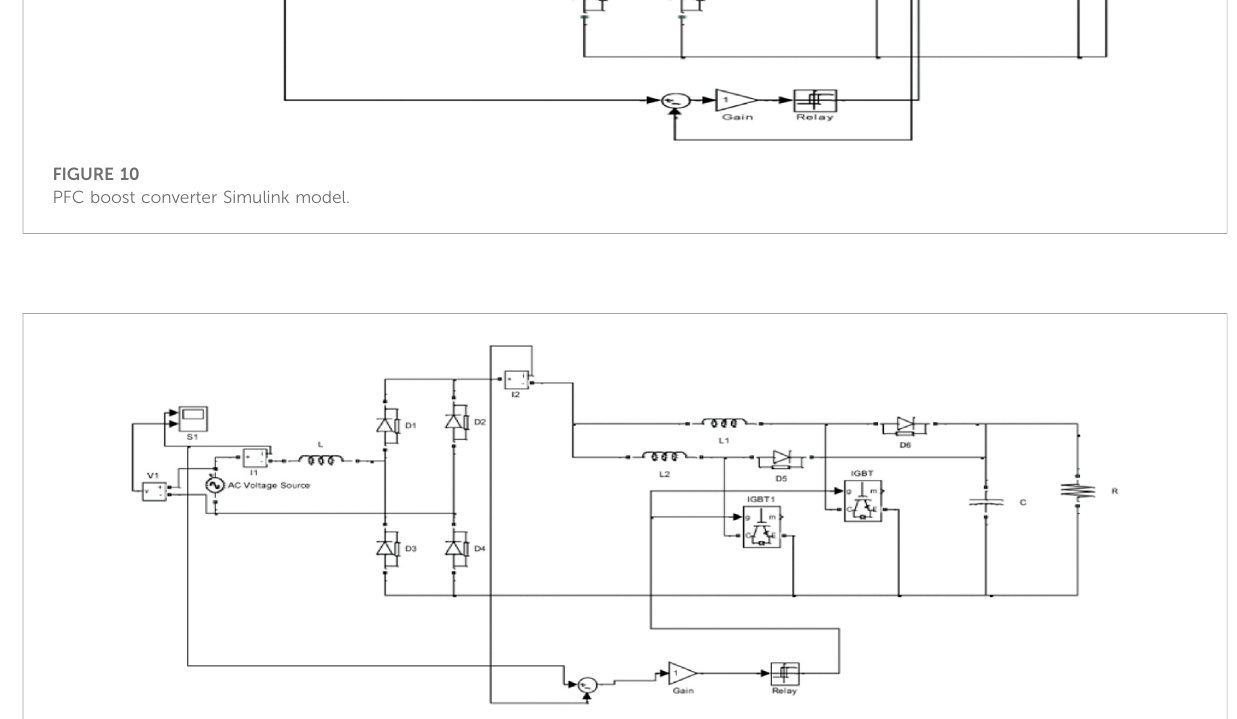
FIGURE 11 PFC double boost converter Simulink